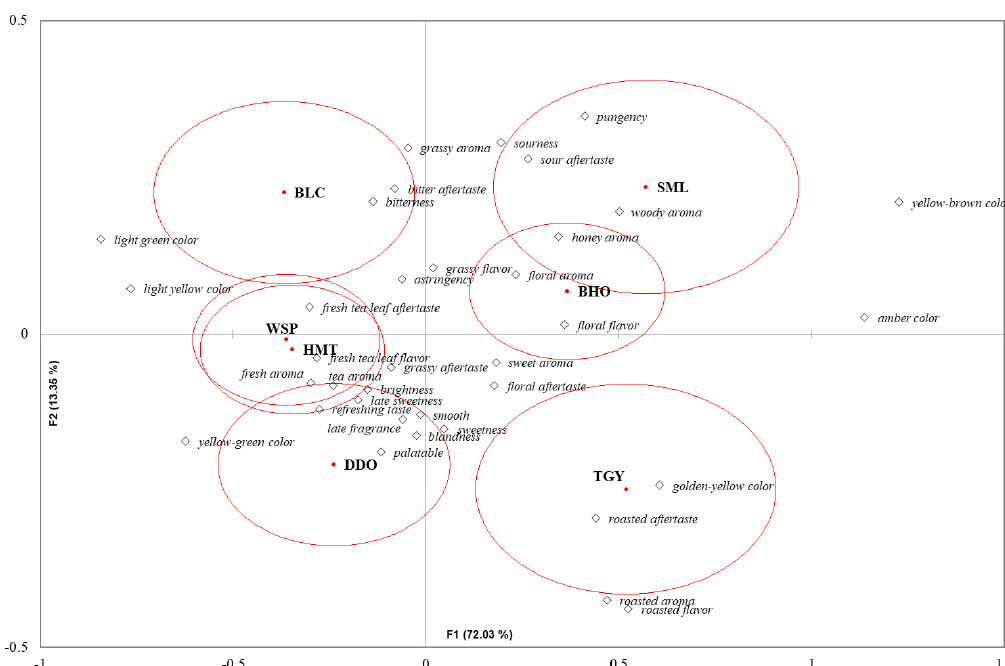
Figure 2. A bi-plot by correspondence analysis of the seven cold tea infusions in association with the 36 sensory attributes selected by more than 20% of participants. Significant difference ( p < 0.05) of panelists’ selection proportions for each attribute among the seven tea samples were determined by Cochran’s Q test. The pairwise post-hoc McNemar test (Bonferroni) was also performed, and the tea samples signed with different alphabet letters were significantly different in the frequencies of panelists’ selection for the attribute listed in the same row. Asterisks are marked on the attributes selected by more than 20% of respondents.